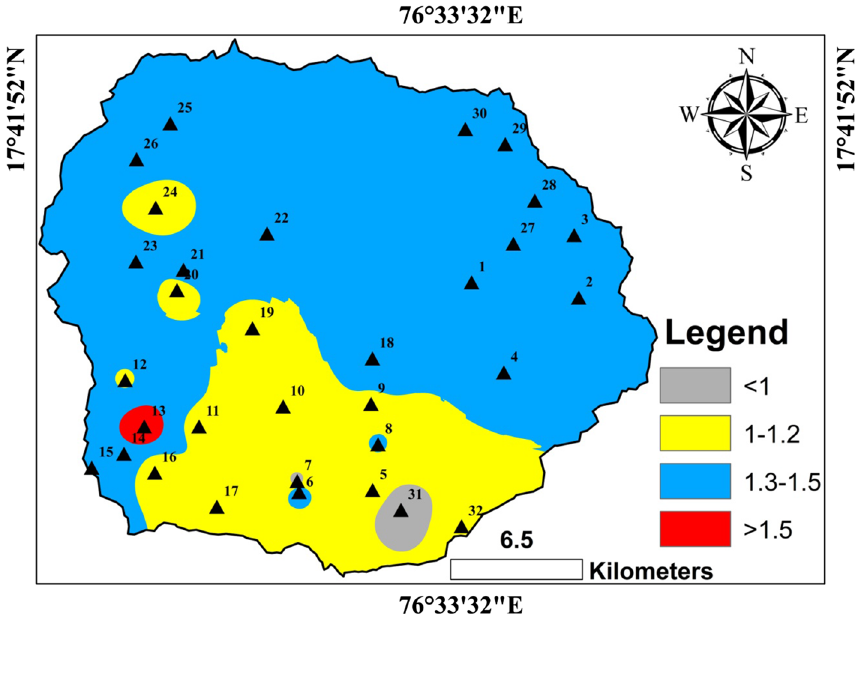
Fig. 25 Geospatial distribution of fluoride